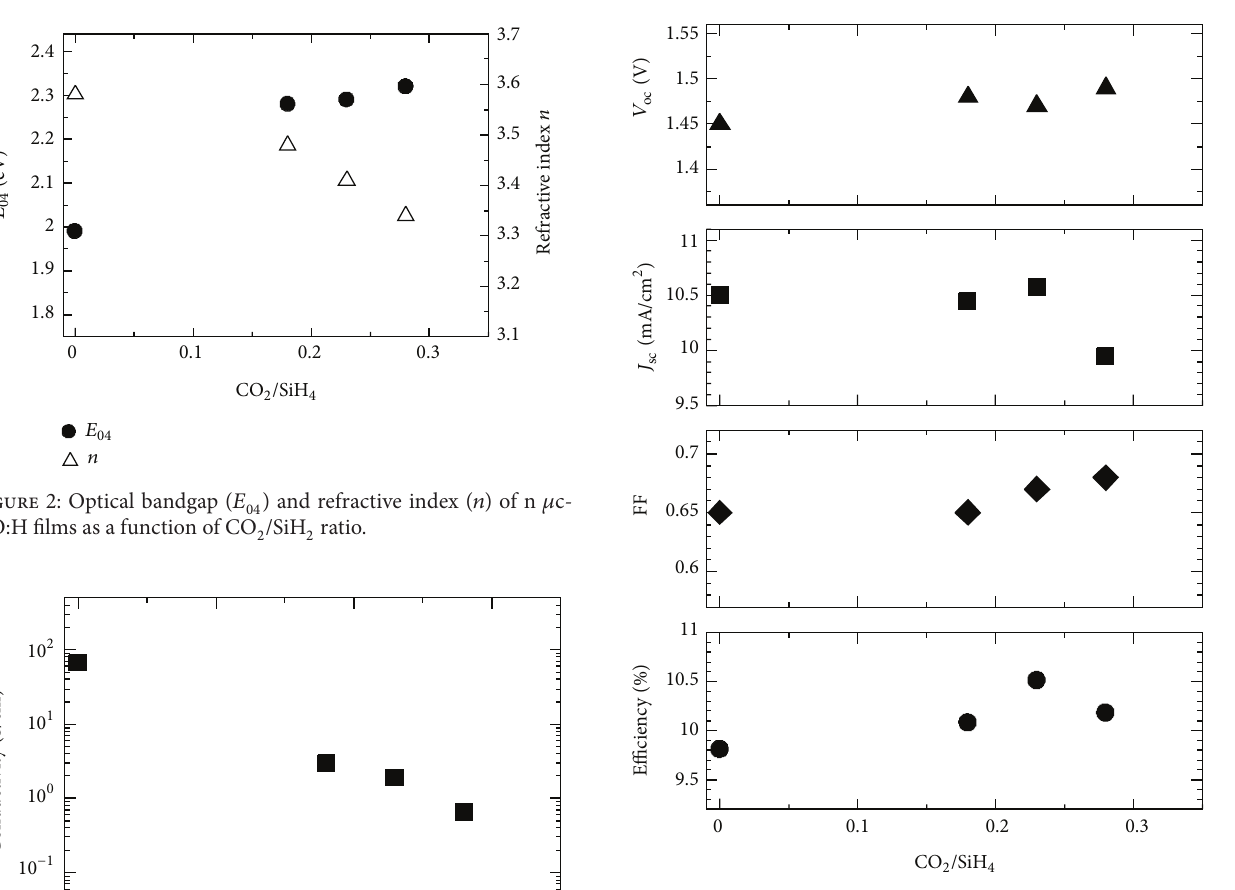
Figure 4: Photovoltaic parameters of a-SiO:H/ 𝜇 c-Si:H micromorph silicon solar cells using n top 𝜇 c-Si(O):H layer deposited with various CO 2 /SiH 2